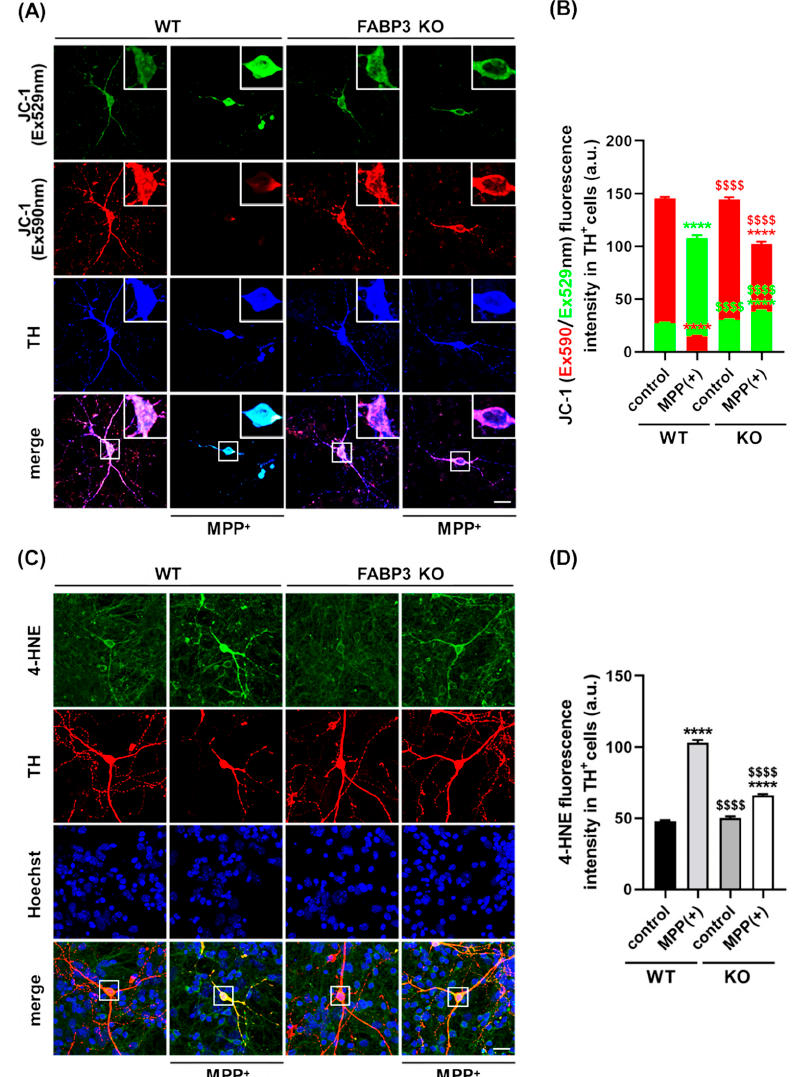
Figure 4. FABP3 is involved in MPP + -induced reduction of mitochondrial activity and ROS production in dopaminergic neurons. ( A ) Representative images of JC-1-stained TH + neurons. The white boxes indicate regions of interest (ROIs), which are magnified in the upper right in each image and quantified to measure the fluorescence intensity. Scale bar: 10 μ m. ( B ) Quantitative analysis of Ex590 (red) and Ex529 (green) fluorescence intensity in JC-1-stained TH + neurons. **** p < 0.0001 versus wild type (WT) control; $$$$ p < 0.0001 versus WT MPP + , n > 20. ( C ) Representative images of TH + neurons (red) stained with anti-4HNE antibody (green). The white boxes show ROIs to measure 4-HNE fluorescence intensity. Scale bar: 10 μ m. ( D ) Quantitative analysis of 4-HNE immunoreactivity in TH + cells. **** p < 0.0001 versus WT control; $$$$ p < 0.0001 versus WT MPP + , n > 20.